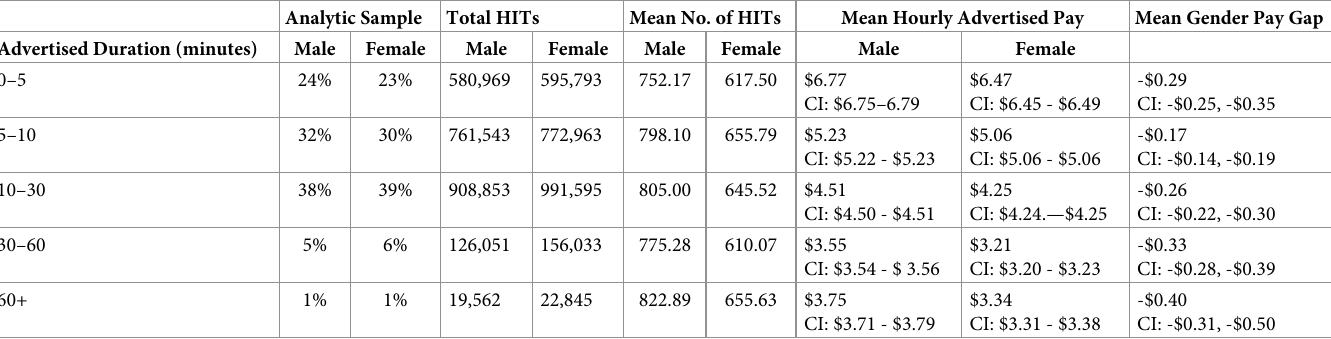
Table 6. Distribution of HITs, average hourly advertised pay, and gender gaps in advertised hourly pay by advertised HIT duration. Analytic Sample Total